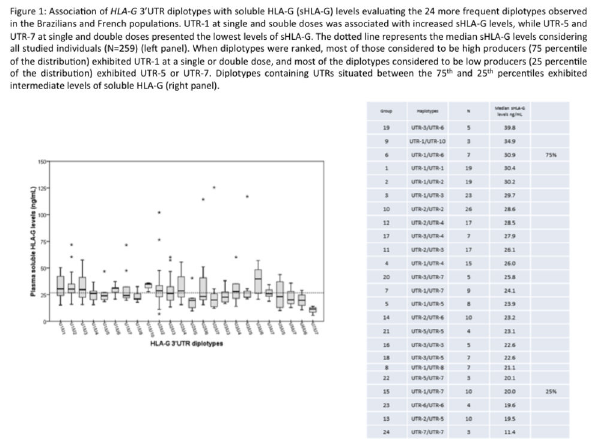
Figure 1. Association of HLA-G 3’UTR diplotypes with soluble HLA-G (sHLA-G) levels evaluating the 24 more frequent diplotypes observed in the Brazilians and French